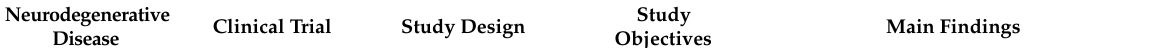
Table 4. Clinical trials investigating the role of ibudilast in neurodegenerative